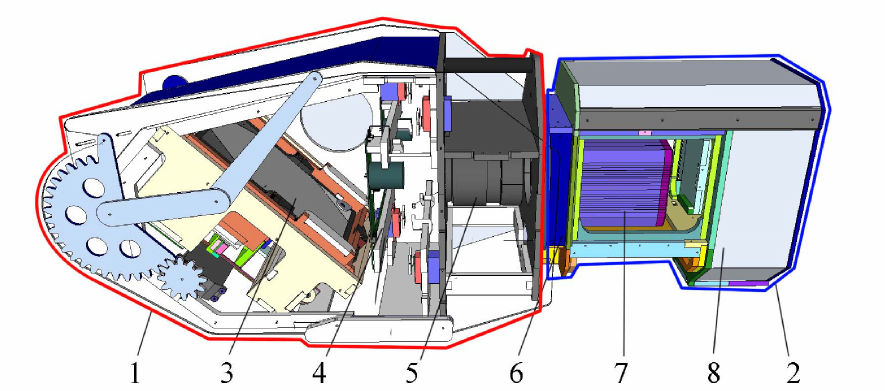
Fig. 1. Schematic view of a single MMT channel. 1 : Coelostat unit; 2 : camera unit; 3 : coelostat mirror that can rotate by (cid:24) 10 ◦ around two axes; 4 : installable color and polarimetric filters; 5 : Canon EF85/1.2 objective; 6 : optical corrector; 7 : Andor Neo sCMOS detector; 8 : conditioner keeping stable environmental conditions inside the channel.